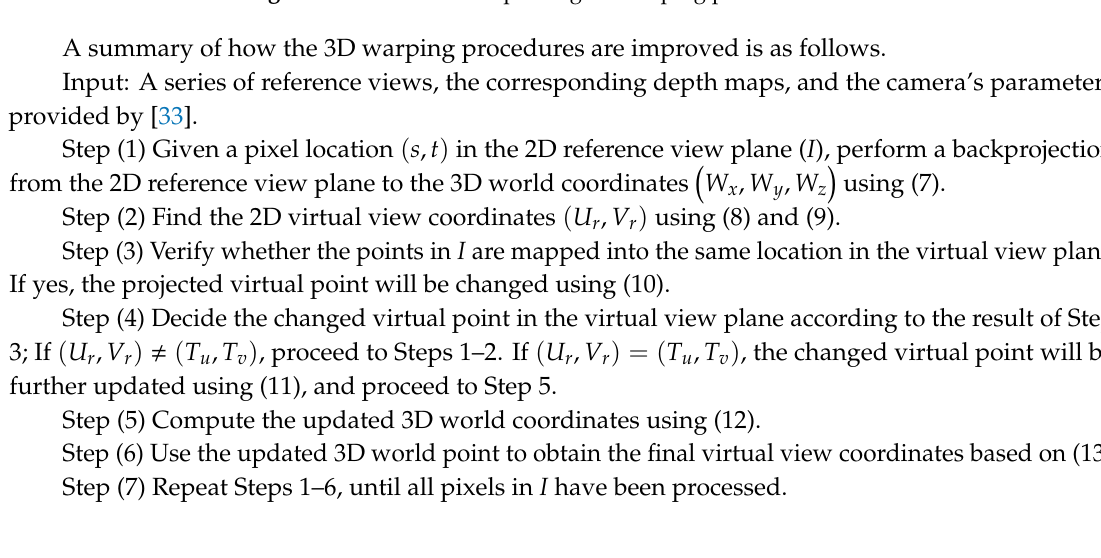
Figure 7. Profile of the improving 3D warping process in